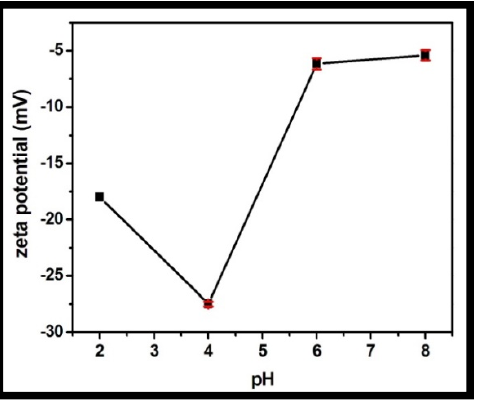
Figure 10. Zeta potential of the prepared rGO-WO 3 heterostructure with respect to pH.